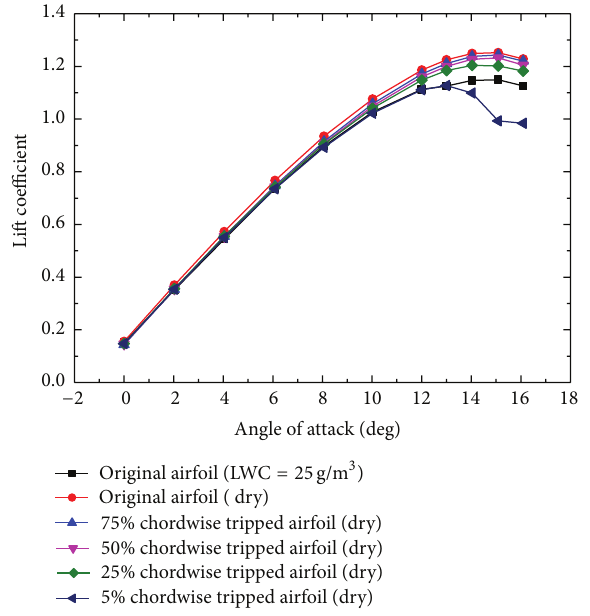
Figure 10: Numerical lift coefficient comparison for different tripped positions.